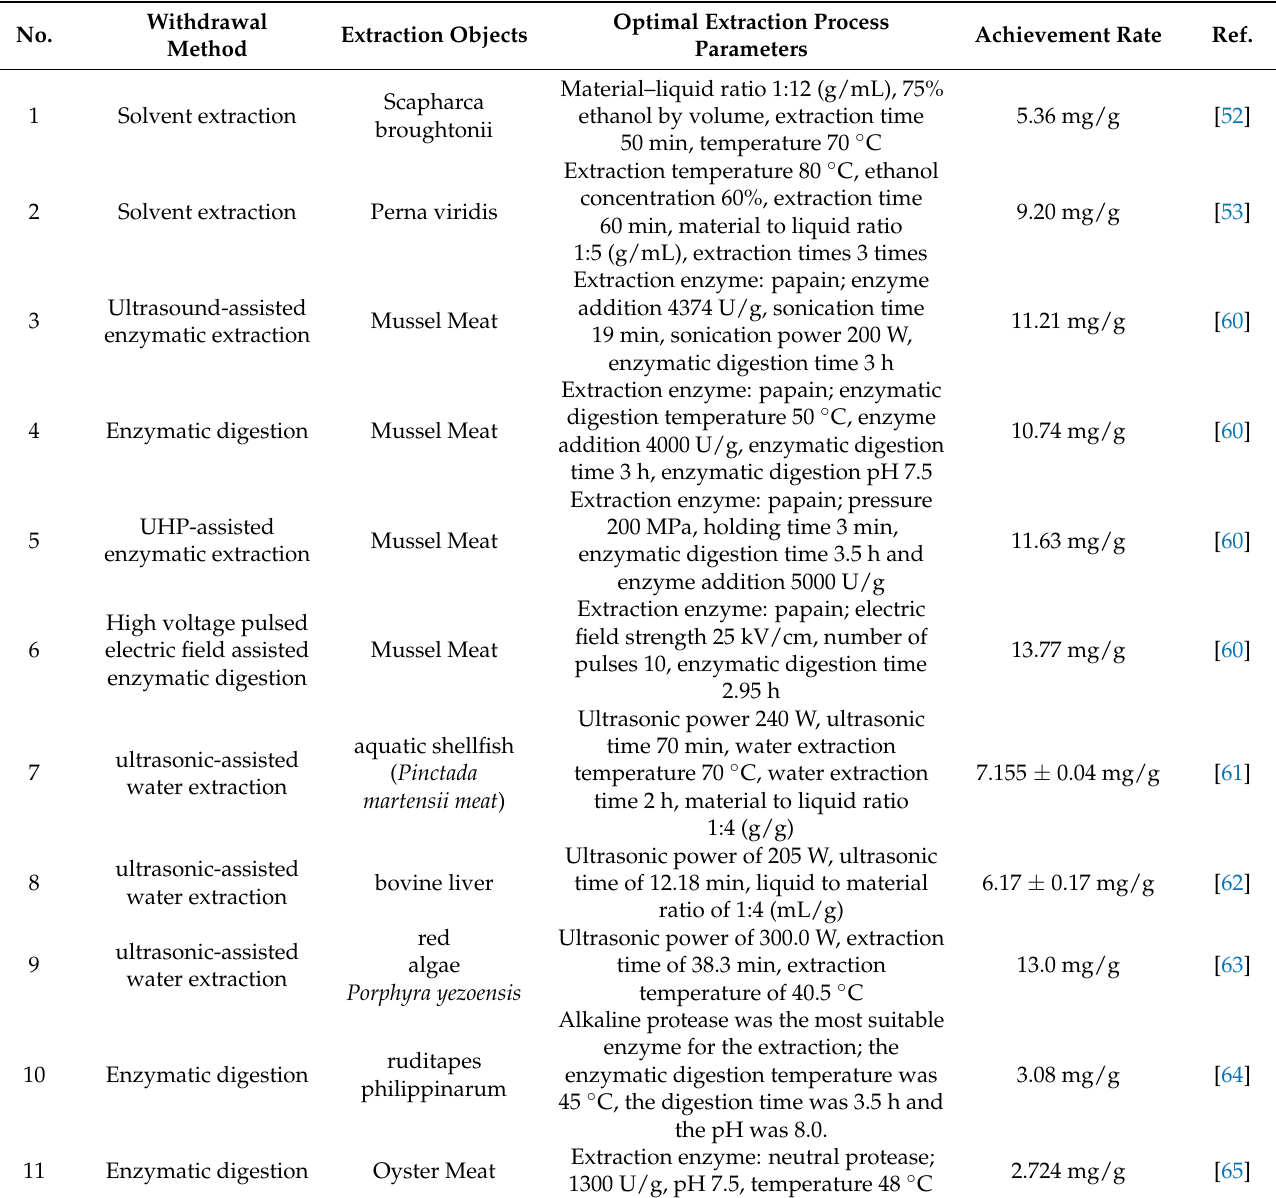
Table 2. Yields of different extraction methods of